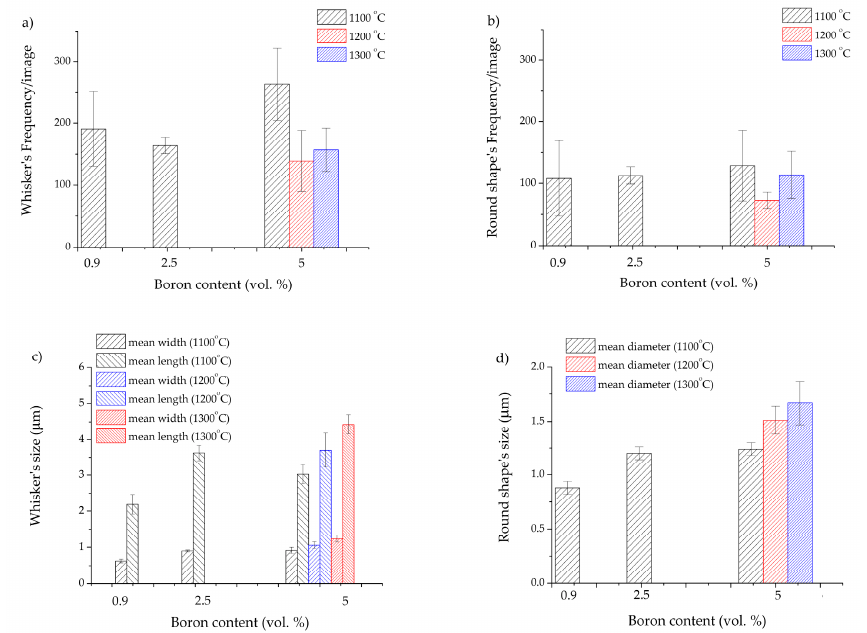
Figure 4. ( a ) Whisker frequency; ( b ) Round shape precipitate frequency vs. Boron content; ( c ) Whiskers size; and ( d ) Round shape precipitate size vs. Boron content.